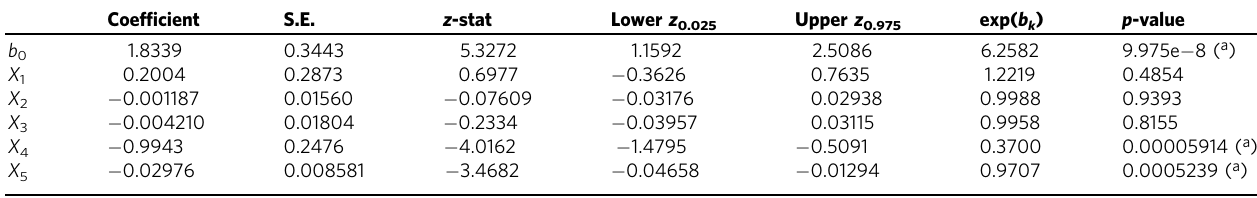
Table 5 Coef fi cients relating category 2 to category 0 of gender. Source: Own elaboration. Coef fi cient